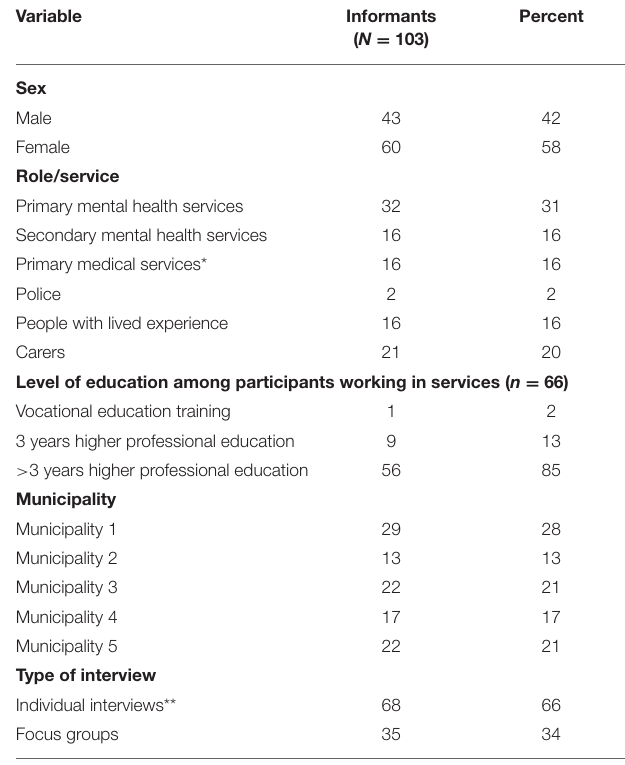
TABLE 1 | Distribution of